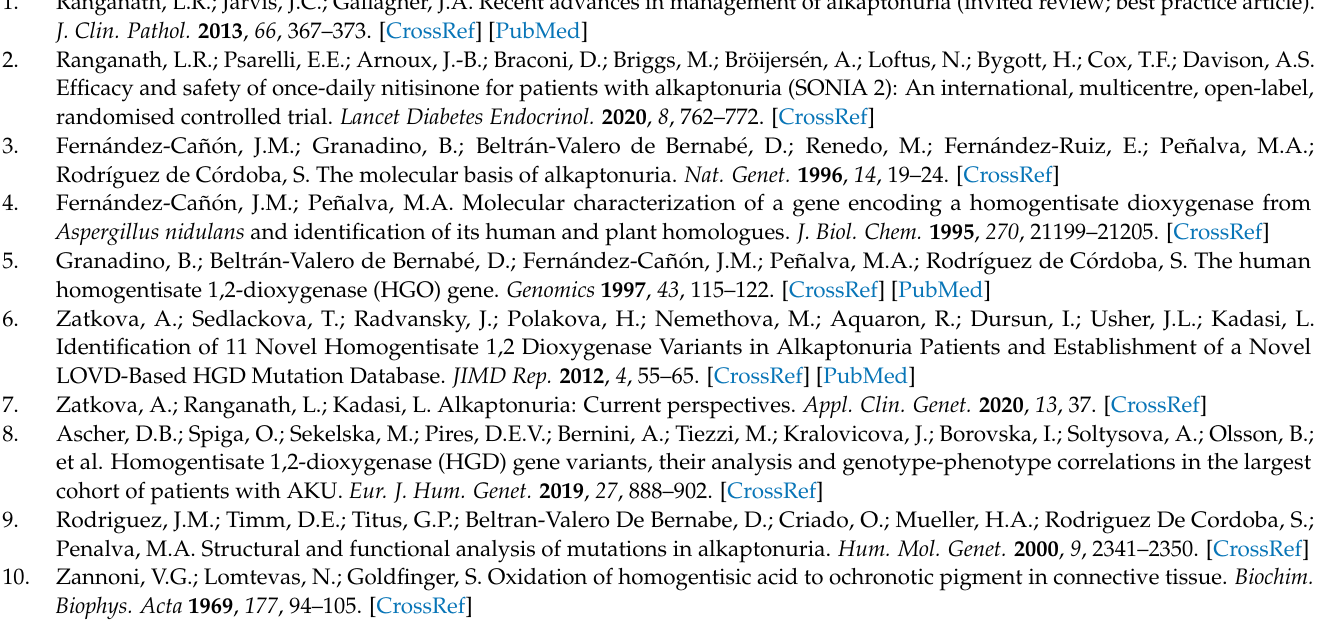
Table S1: Complete list of individual mutations in siblings analyzed in the study. Table S2: AKUSSI scores for selected symptoms in the discussed sibships. Table S3: Biomarker concentrations in the discussed